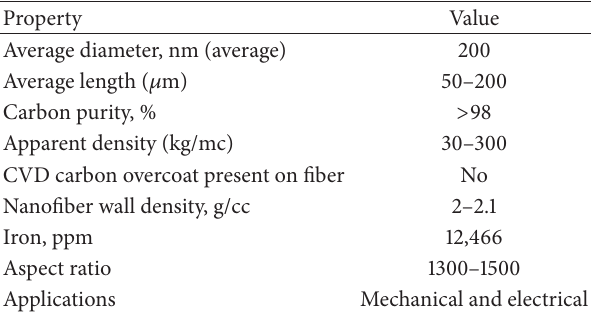
Table 3: Properties of